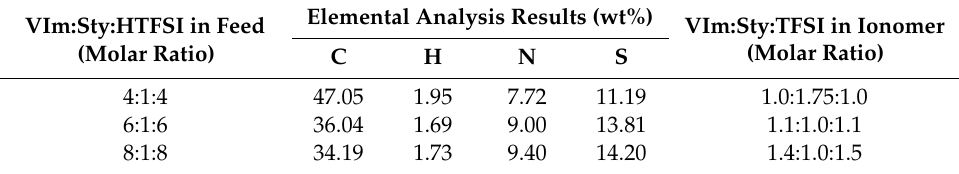
Table 2. Elemental analysis and the calculated molar ratio of different segments for PS 1 -b- P(VImH + ) n TFSI polymerized from different mixed monomer solutions. Elemental analysis and the calculated molar ratio of di ff erent segments for PS 1 -b-P(VImH + ) n TFSI polymerized from di ff erent mixed monomer solutions.